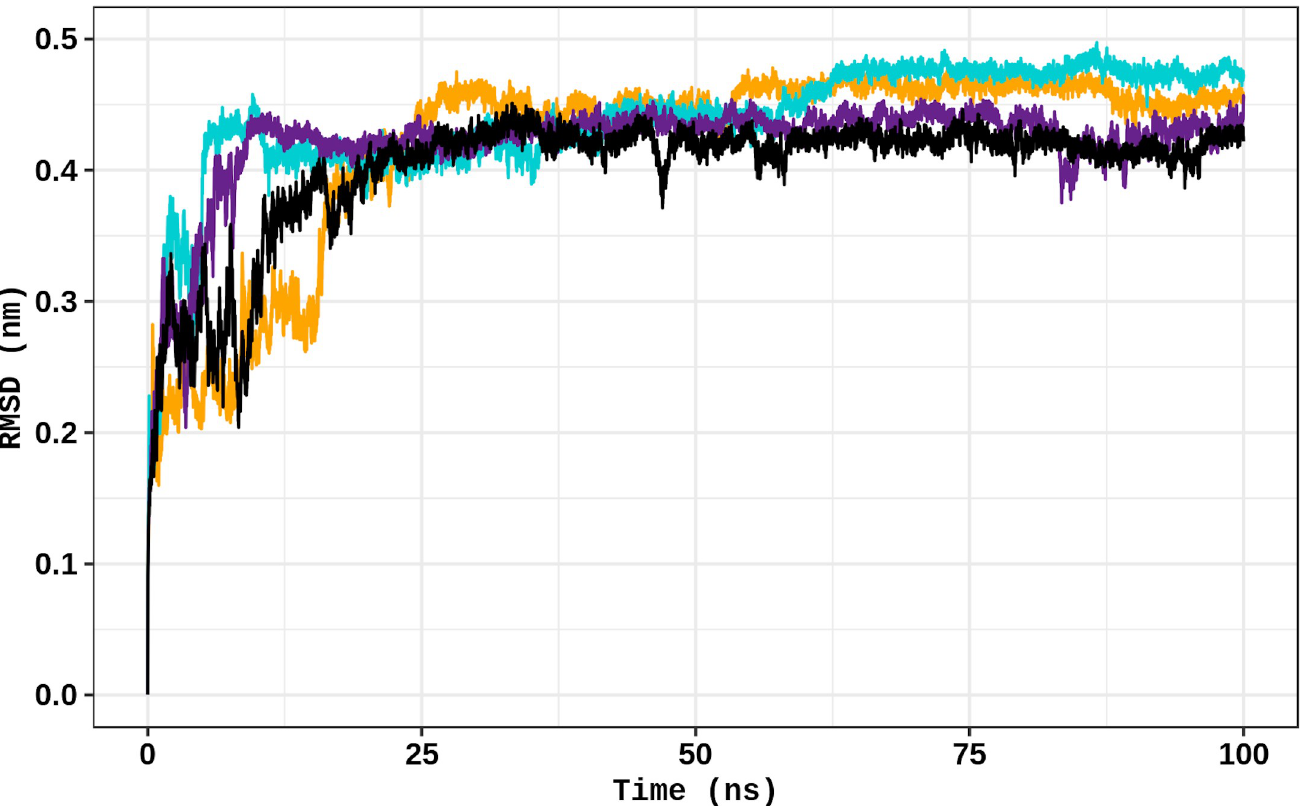
Fig 4. Backbone RMSD of WT TPH2 and its variants. The RMSD for the backbone atoms of TPH2 WT and variants at 300 K is shown as a function of time. WT is represented in black, variant P206S is represented in dark yellow, variant R303W is represented in purple, and variant R441H is represented in turquoise.